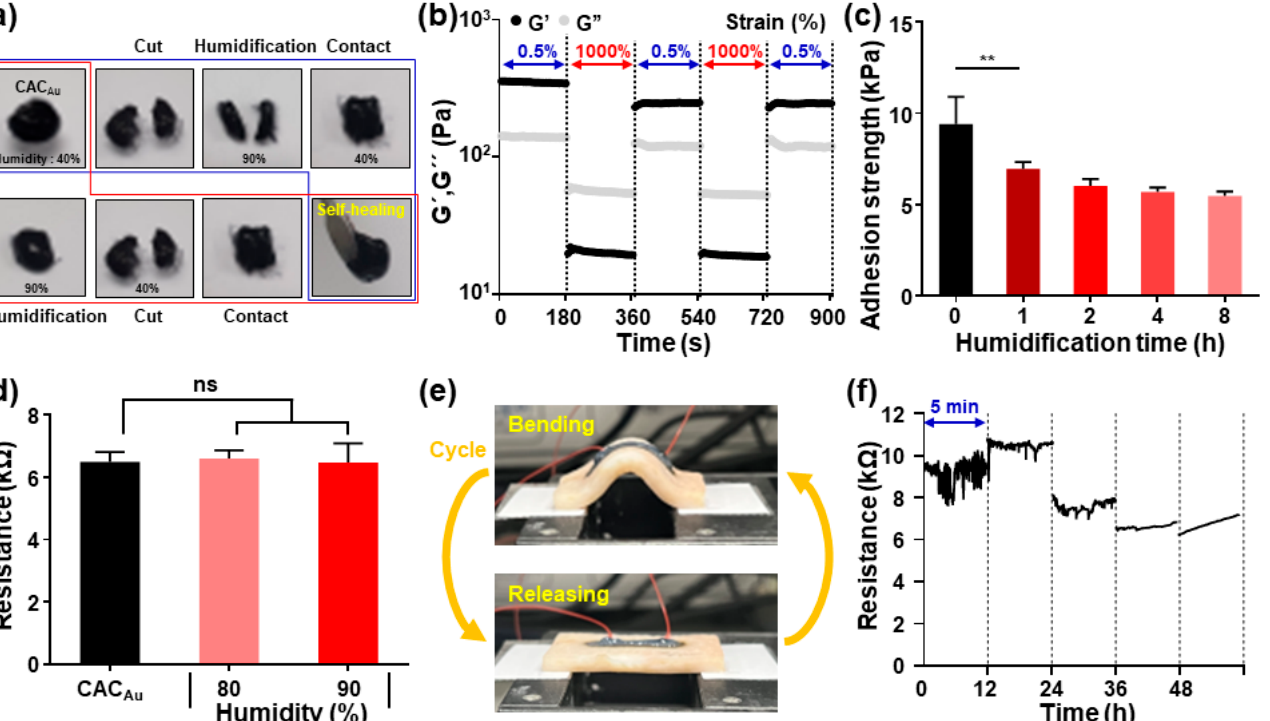
Figure 7. Stability of self-healing property, adhesiveness, and electrical resistance of CAC hydrogels. ( a ) Photos to show self-healing behavior of CAC Au hydrogels under humidified condition (90%), and ( b ) their G’ and G” values recovered under alternating strains of 0.5% and 1000% after 2-hour incubation of the hydrogels in 90% humidity chamber. ( c ) Shear adhesion strength of the CAC Au hydrogels as a function of incubation time in 90% humidity chamber. ** p < 0.01, one-way ANOVA. ( d ) Electrical resistance of the hydrogels under high relative humidity (80 or 90%). ns for not signif- icant, one-way ANOVA. ( e ) Experimental settings to measure electrical resistance of the CAC Au fil- ament directly printed on porcine skin tissue during bending/releasing cycle. ( f ) Changes in the resistance of the printed filament during the cyclic deformation every 12 h (total 48 h).